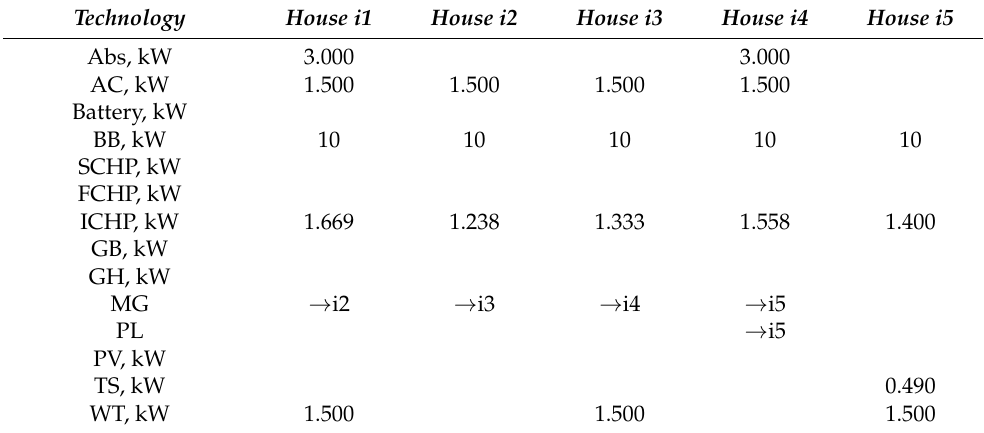
Table 9. Integrated DER technologies installations for the Unset network scenario with dynamic export